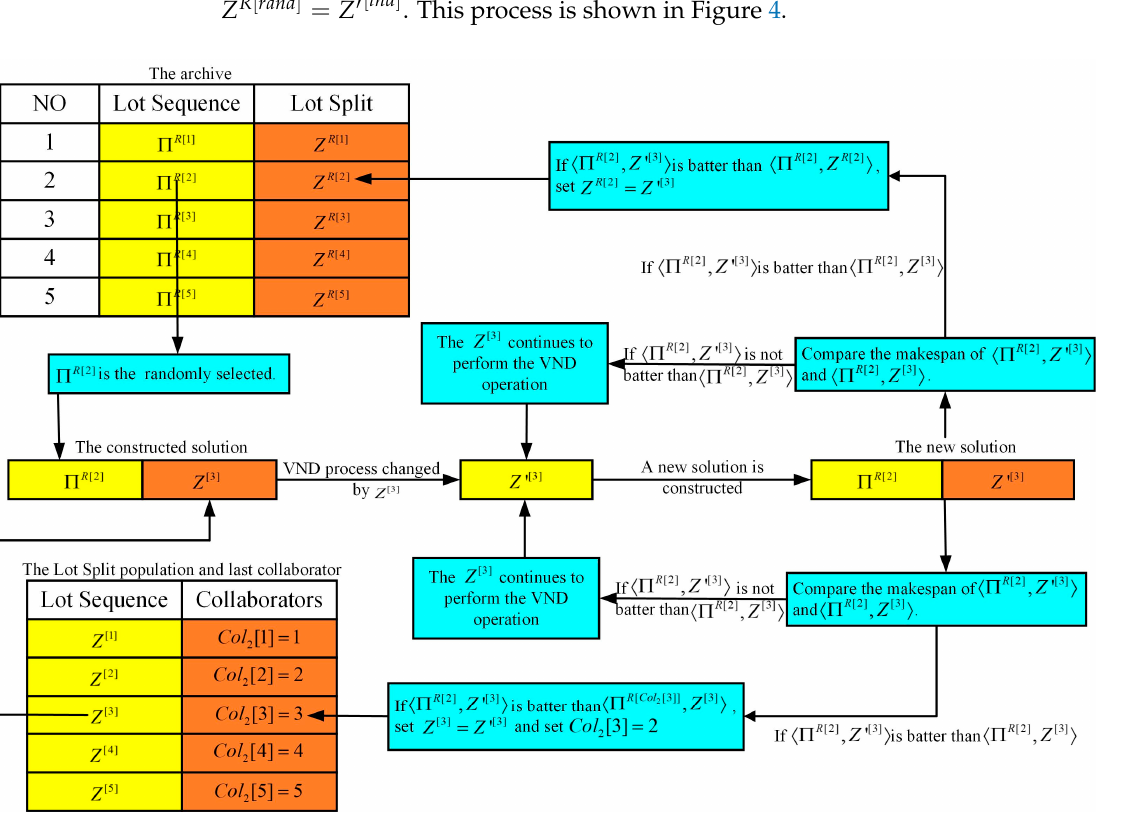
Figure 5. Illustrations of the lot split mutation. Algorithm 2 Evolution of the lot split population 1: Define a set of neighborhood structures